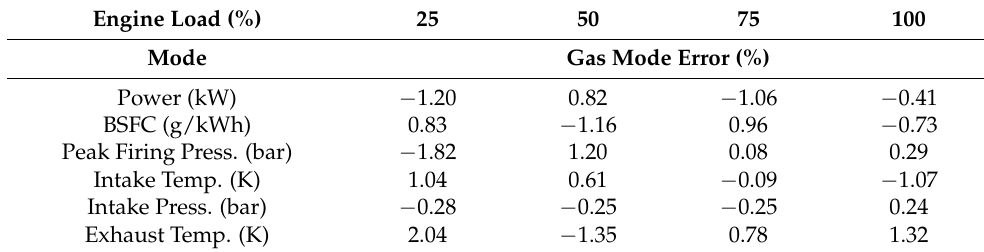
Table 4. Calculation errors of the parameters in gas mode.